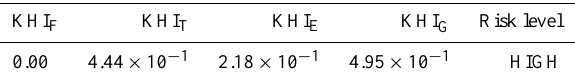
Table 7. List of tanks divided by storehouse (a, b, c), quantity of substance stored for each tank, and corresponding index of weighted mass used in the case-study 3.